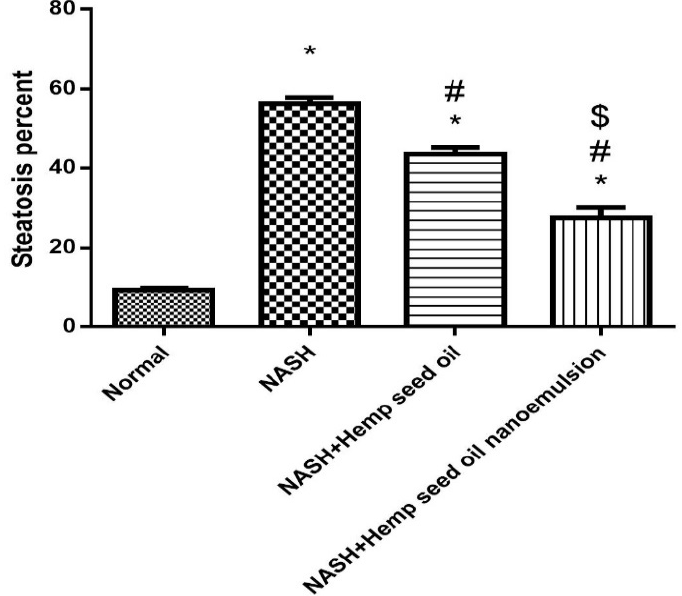
Figure 6. Steatosis score in the hepatic tissues stained with hematoxylin and eosin. Steatosis areas were measured in each microscopic image by labeling the fatty spaces by ImageJ software in images captured at × 400 magnification. Data were processed for statistical analysis using the one-way ANOVA and then Bonferroni’s test for pair-wise comparison at p < 0.05. Data are expressed as means ± SD. * Different from normal group, # Different from the NASH group. $ Different from NASH+ hemp seed oil group at p < 0.05.